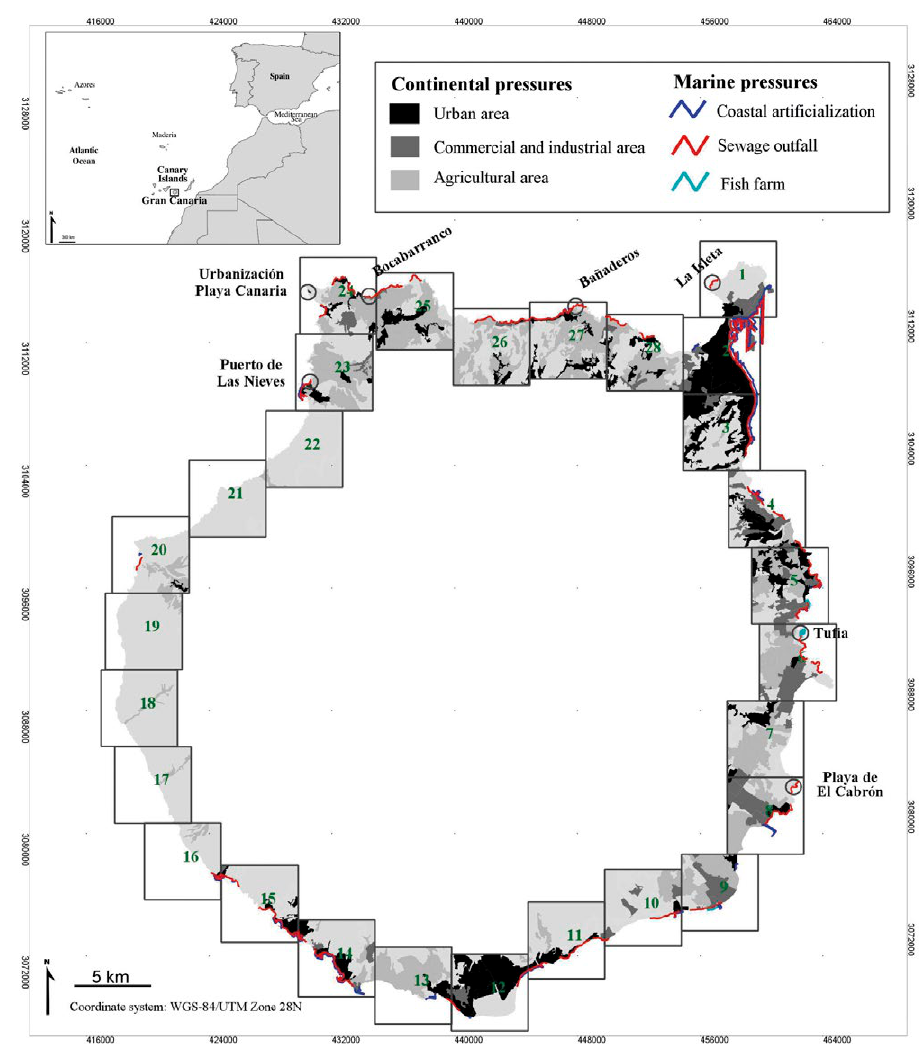
Fig. 1. – Map of Gran Canaria Island, including the 28 sectors (grids of 5×5 km) encompassing the entire coastal perimeter. The location of the seven analysed populations is also shown, with the circular area (500 m radius) where the HAPI index was calculated.